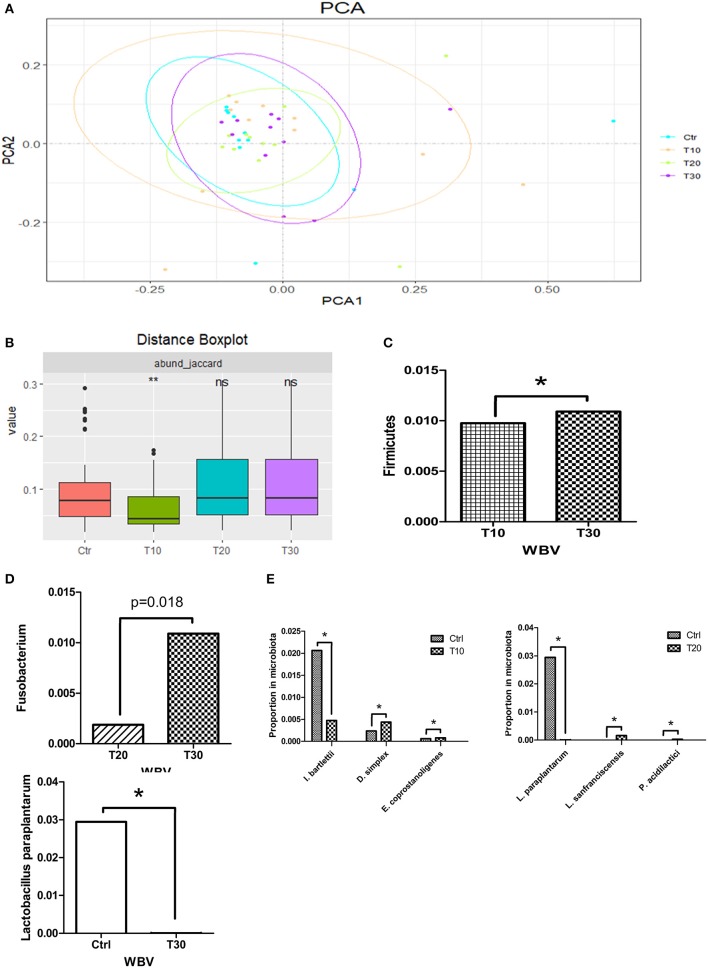
WBV also affects the composition of the human intestinal microbiota and changes the content of Lactobacillus spp. (A) PCA result of the human intestinal microbiota; (B) β diversity distance of the human fecal microbiota; phyla (C), genera (D), and species (E) with significant variation concomitant with longer time of vibration. *p < 0.05; **p < 0.01.